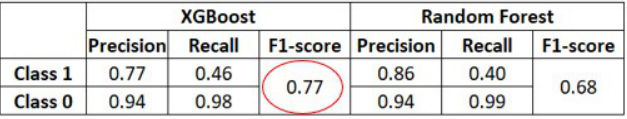
Figure 9. Comparison of result through different